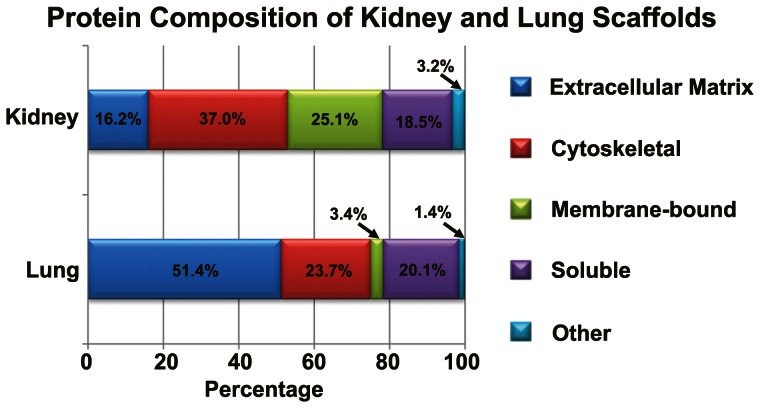
Protein composition of kidney and lung scaffolds.Compositional breakdown of proteins found in kidney and lung.